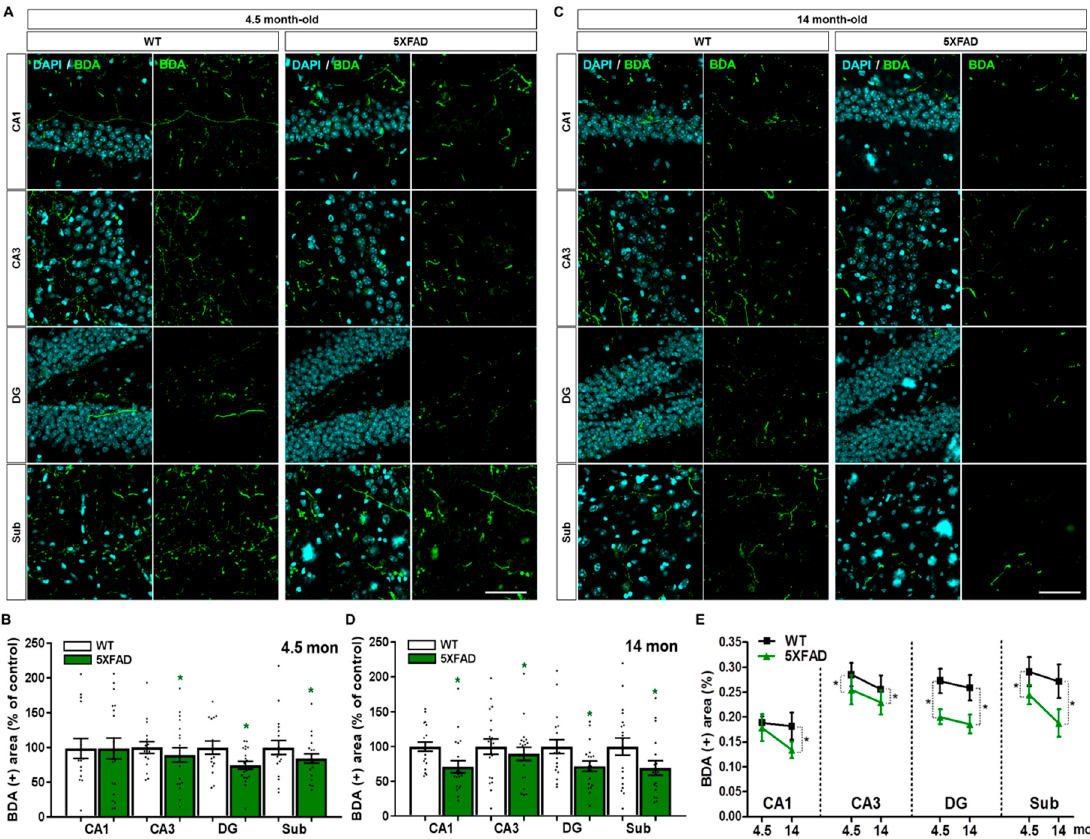
Figure 7. Degeneration of the septo-hippocampal pathway in WT and 5XFAD mice. ( A ) Representative images of BDA-labeled axon terminals in the CA1, CA3, DG, and Sub of WT and 5XFAD mice at the age of 4.5 months. ( B ) Quantification of the BDA-positive area in the hippocampal formation of 4.5-month-old WT and 5XFAD mice. ( C ) Representative images of BDA-labeled axon terminals in the CA1, CA3, DG, and Sub of WT and 5XFAD mice at the age of 14 months. ( D ) Quantification of the BDA-positive area in the hippocampal formation of 14-month-old WT and 5XFAD mice. ( E ) Comparison of BDA-positive area in the septo-hippocampal degeneration by aging and AD progression. Scale bar = 100 µ m. * p < 0.05 indicates significant di ff erences between the WT and 5XFAD mice of the same age (n = 20–35 images/group).